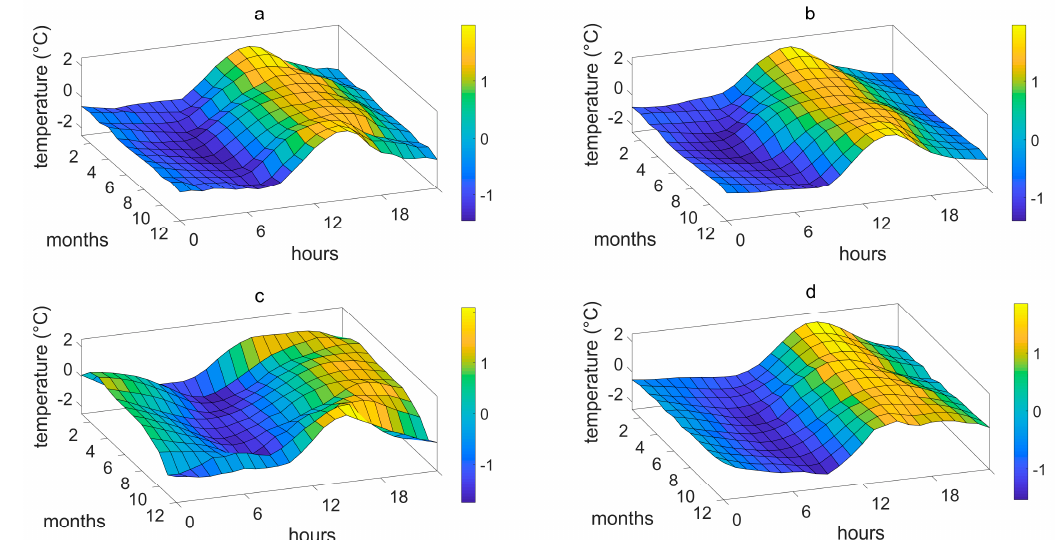
Figure 7. Surface plots of seasonally adjusted and normalised average hourly values of air and water temperature in Suceava city area in 2019: ( a ) air at Suceava Weather Station, ( b ) air in the floodplain, ( c ) Suceava River upstream and ( d ) Suceava River downstream.